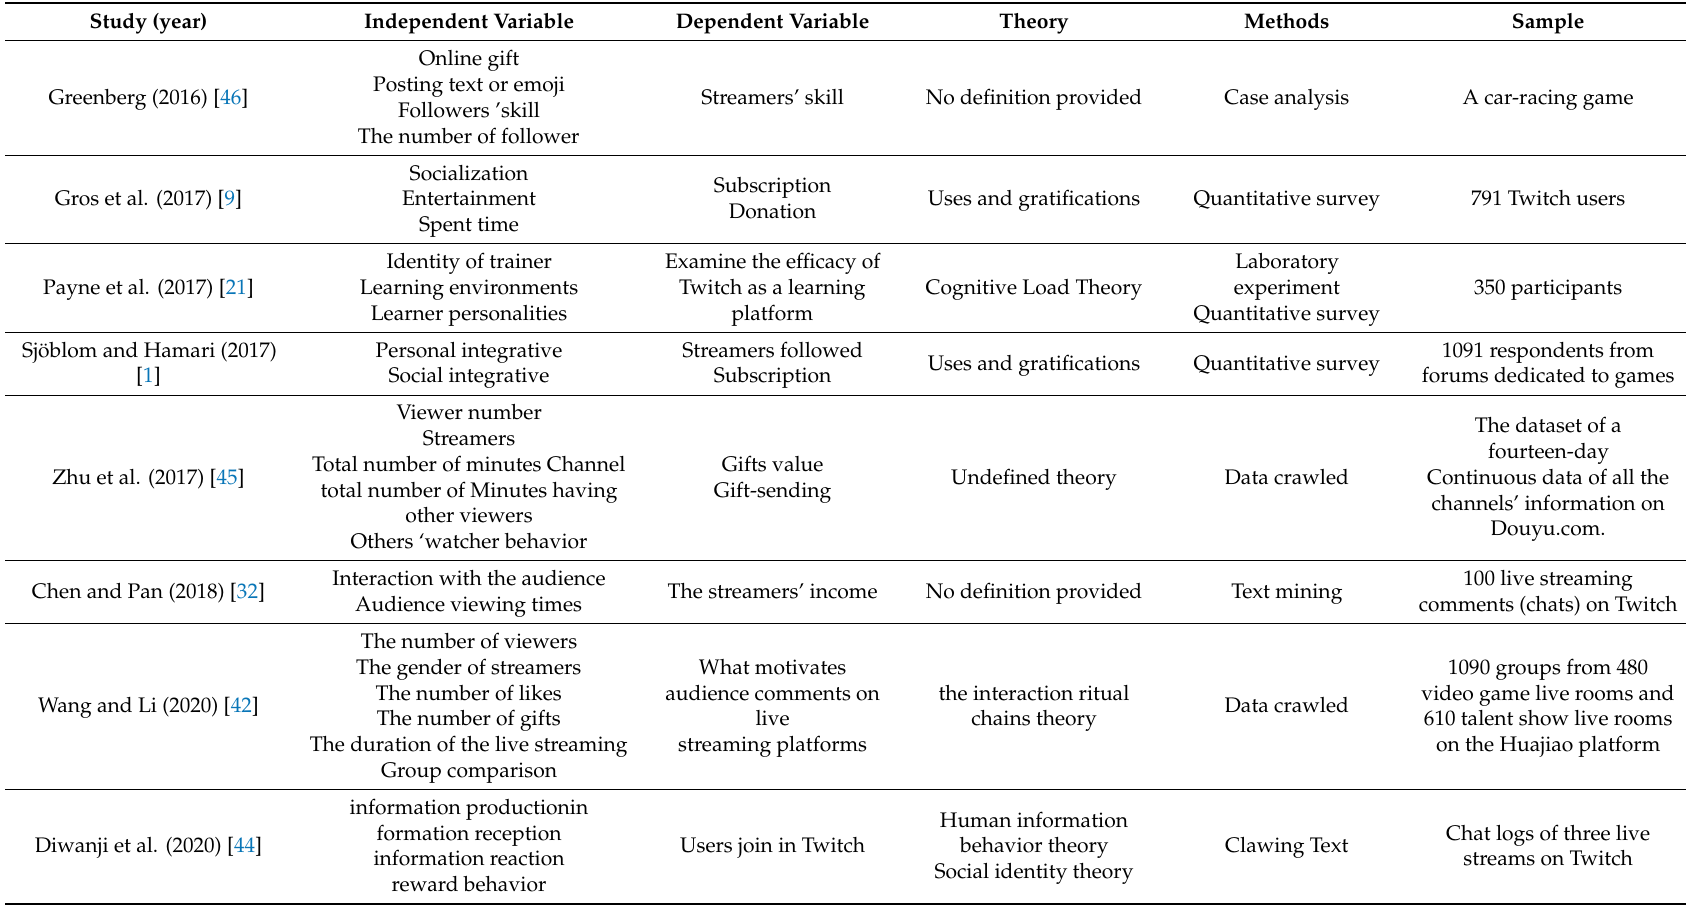
Table A3. Summary of studies included in the interaction between audience and